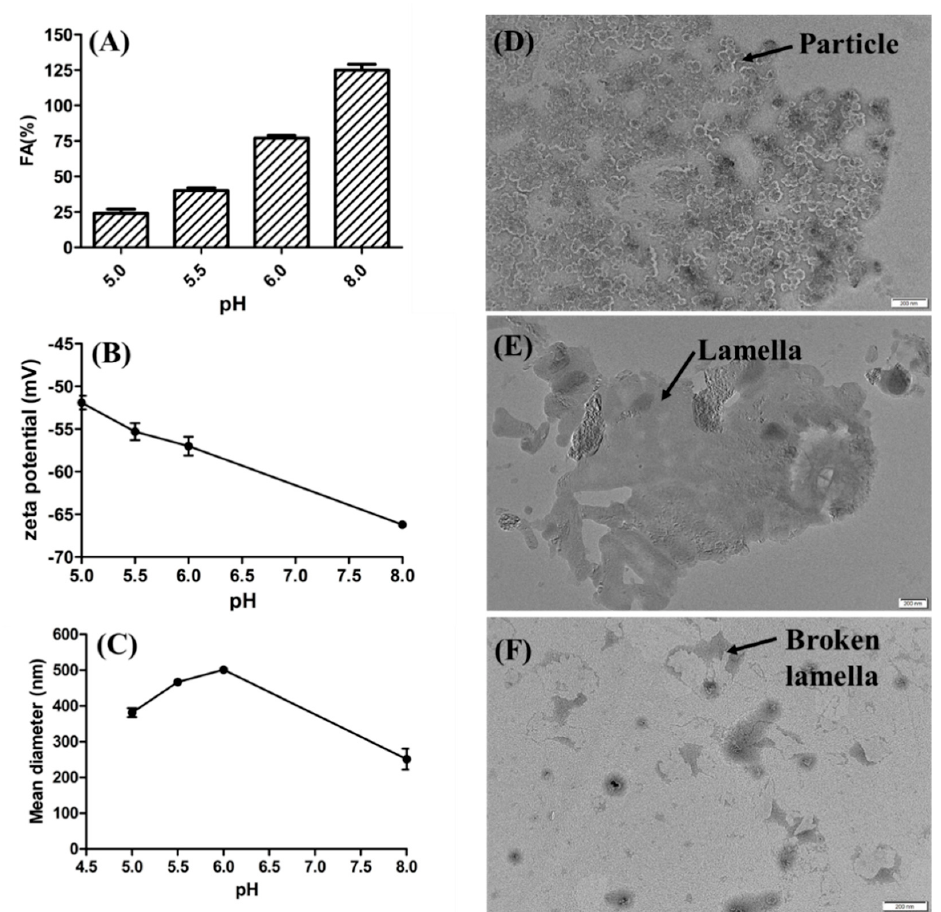
Figure 8. Characterizing the effects of zeta potential and aggregation behavior of rhamnolipids on foaming behavior. ( A ) Foaming ability (FA) of rhamnolipid solutions; ( B ) zeta potential of rhamnolipid solutions; the average diameter of particles of rhamnolipid solutions at pH 5.0 − 8.0 ( C ); TEM micrographs of rhamnolipids at pH 5.0 ( D ), pH 5.5 ( E ) and pH 6.0 ( F ).